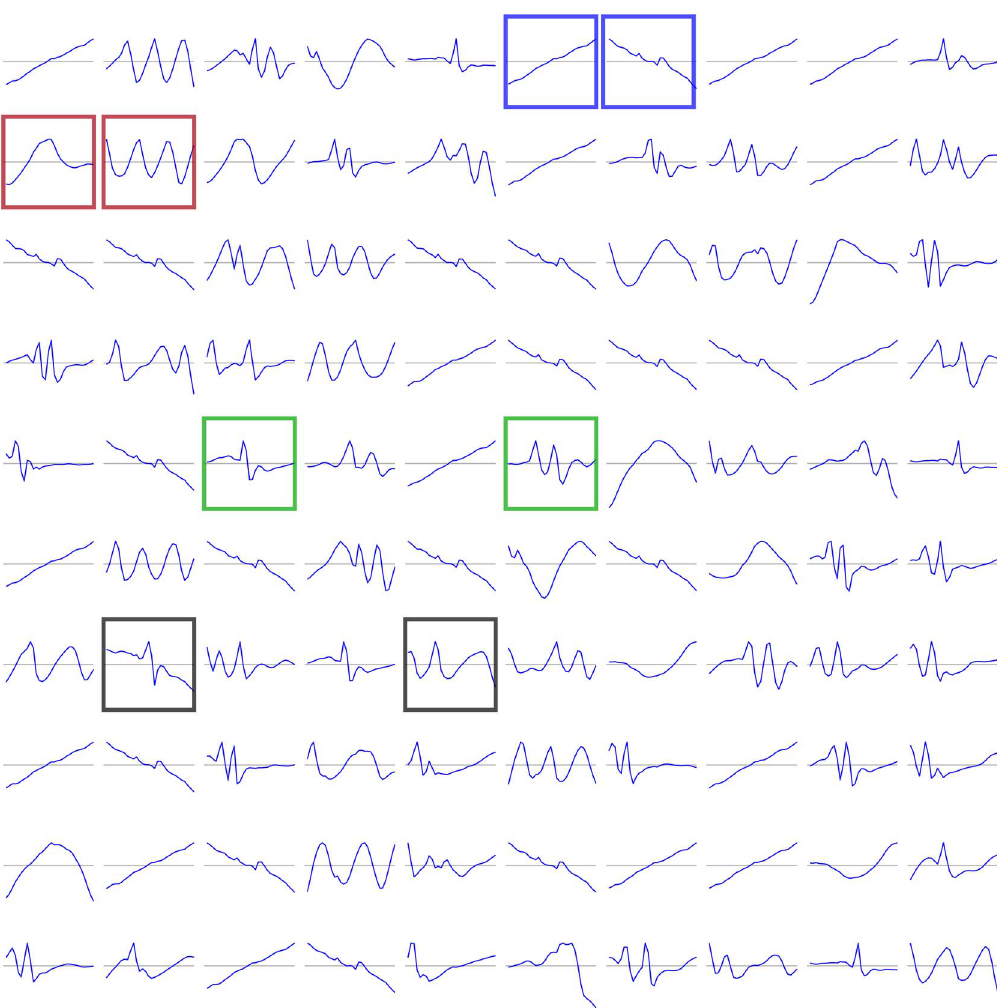
Figure 2. First-layer learned features are simple functional element detectors, in various combinations and phases. For example, uphill- and downhill-ramp detectors (blue), single- and multiple-spot detectors/Fourier components (red), short- and long-edge detectors (green), and mixed-element detectors (grey). These features are visualized directly as the normalized rows W i .